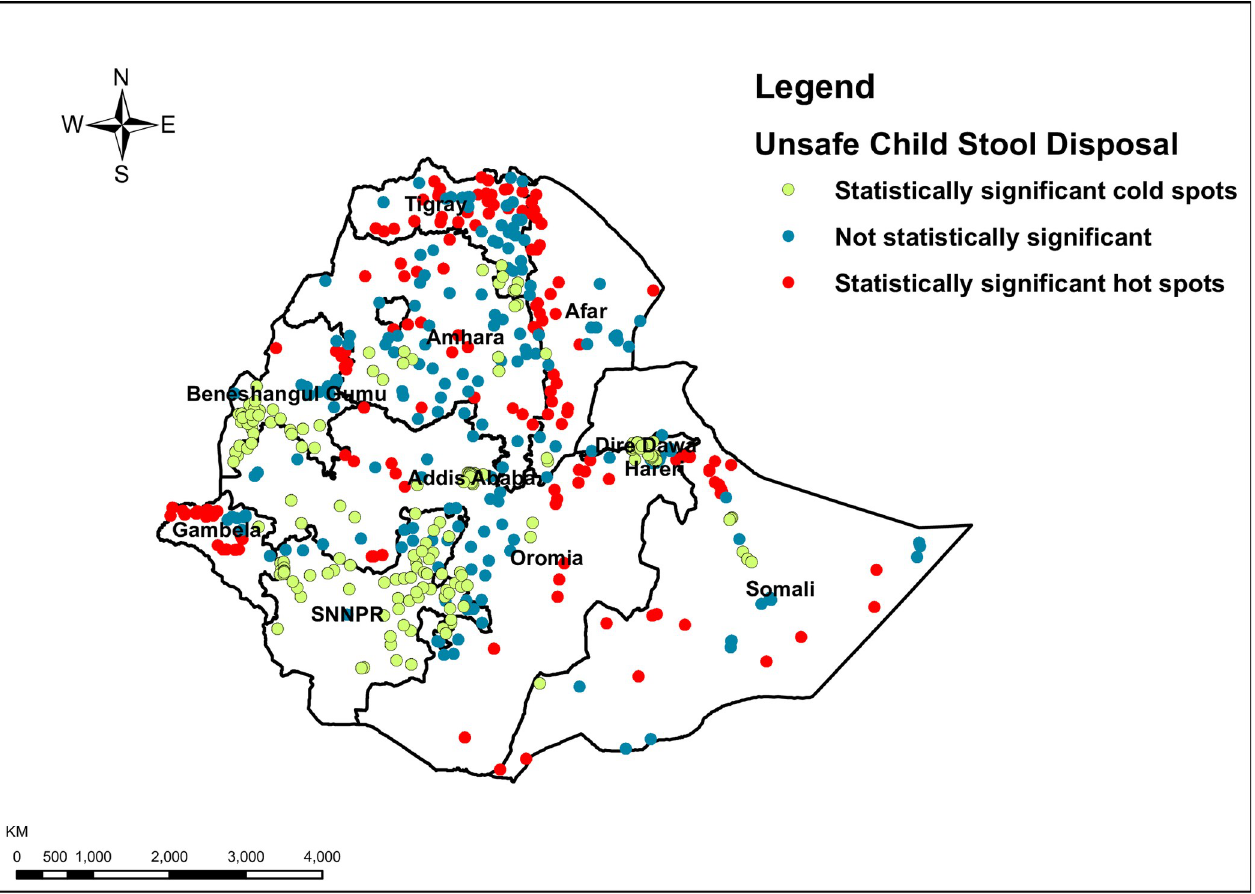
Fig 1. Hotspot and cold spot analysis using Getis-Ord Gi statistics of unsafe child stool disposal in Ethiopia: A single dot on the map represents one enumeration area, EDHS 2016. Source: Shapefile of the map was freely available from https://africaopendata.org/dataset/ethiopia-shapefiles.